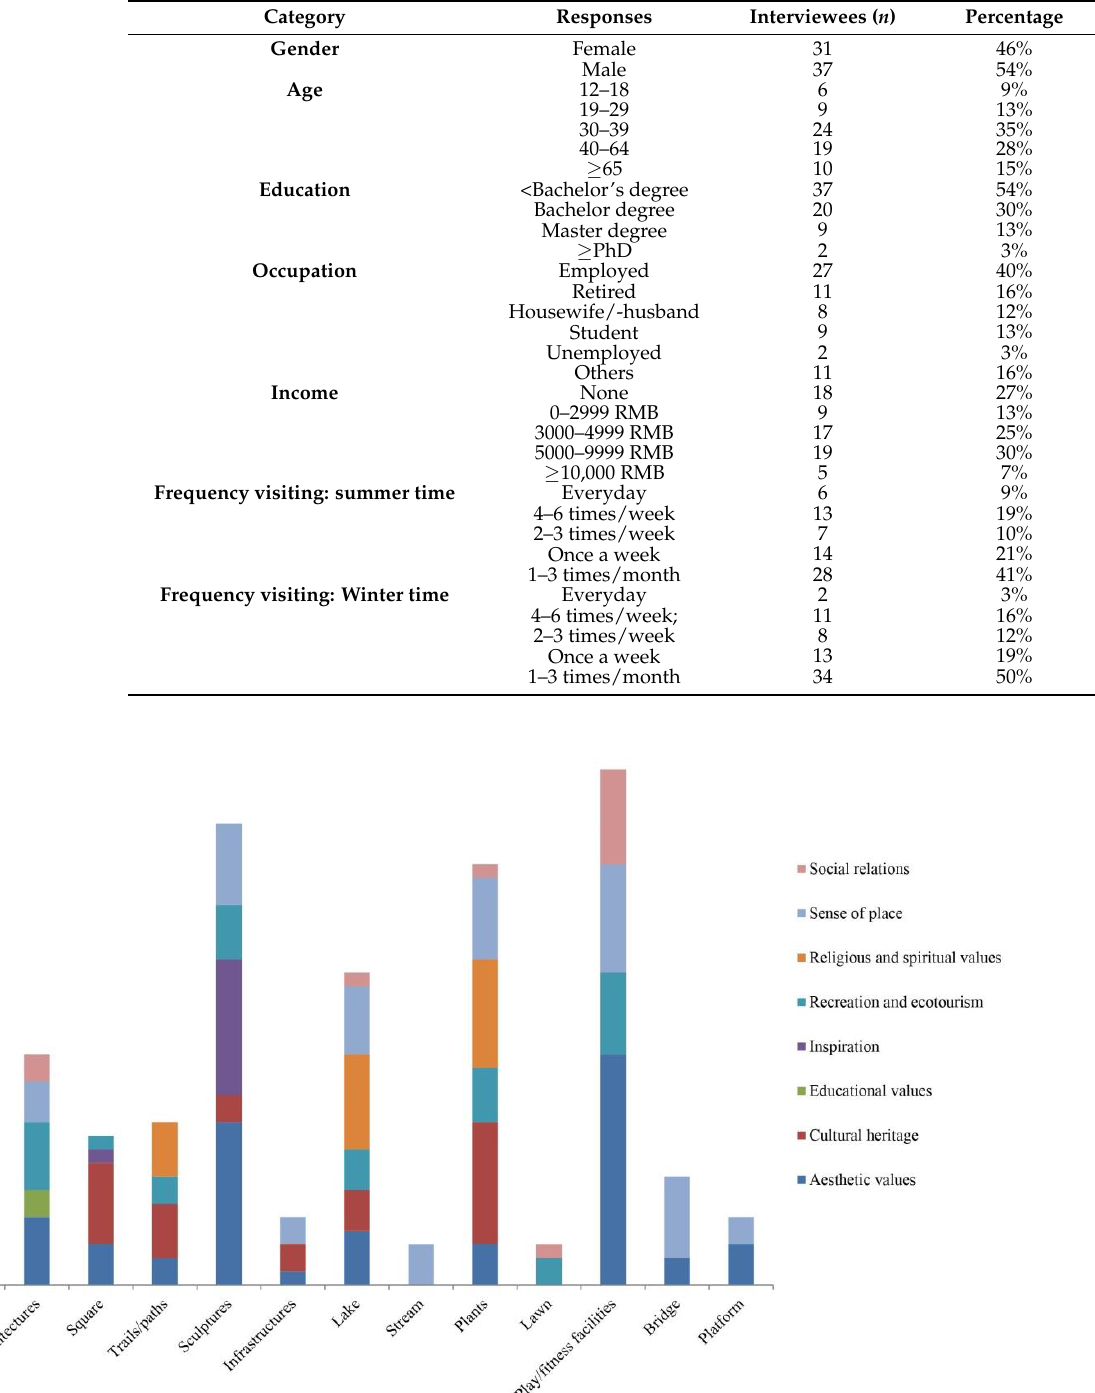
Table A3. Socio-demographic characteristics of the 68 participants.